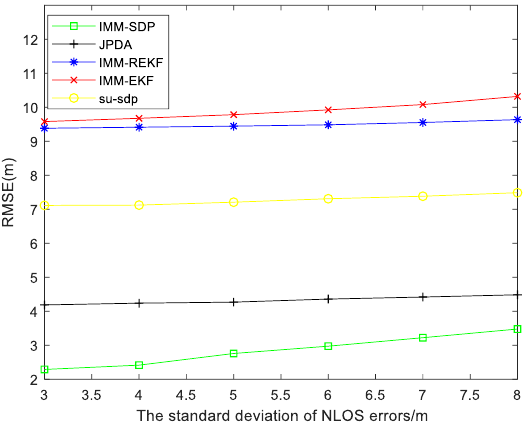
Figure 5. RMSE versus the standard deviation of NLOS errors.